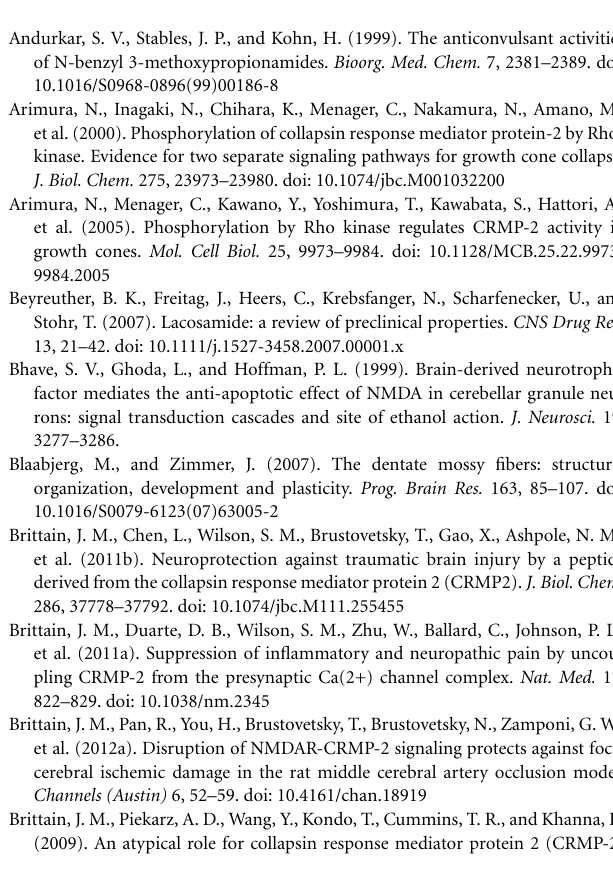
indirectly reduces levels of GSK3 β -phosphorylated CRMP2 through a loss of priming, resulting in an overall increase in the proportion of active CRMP2. (C) Despite the sustained increase in unphosphorylated (active) CRMP2 in the hippocampus, the role of CRMP2 in aberrant mossy fiber sprouting following injury remains unclear, as denoted by the